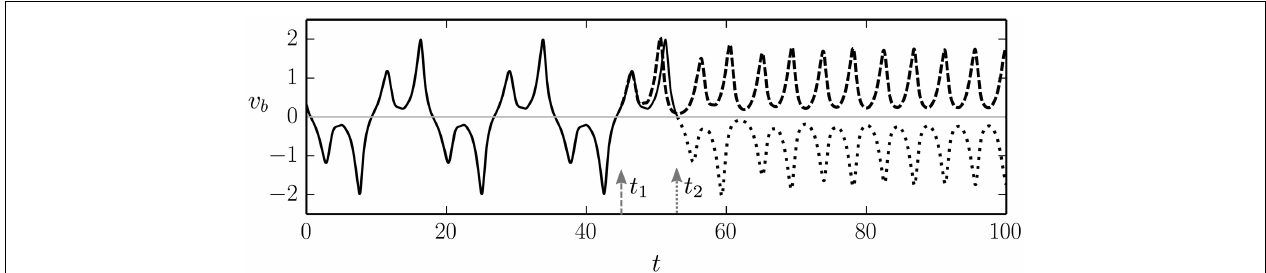
FIGURE 7 | Two superimposed runs for the time evolution of the speed v b of the barrel (black lines), for a =1.9 . In the first run, the adaption rate ε is changed discontinuously at time t 1 = 45 from ε = 0.017 (corresponding to the stationary back-and-forth mode, see Figure 6 ) to ε = 0.02 (corresponding to the 1:1 rolling mode). In the second run, identical initial conditions have been used and an identical change is made to the adaption rated ε , but now at time t 2 = 53. In both runs (dashed and dotted lines, respectively), the barrel settles into the 1:1 rolling motion, albeit in opposite directions (to the left/right with ⟨ v b ⟩ > 0 and ⟨ v b ⟩ < 0, respectively). For the corresponding videos, see the Supplementary